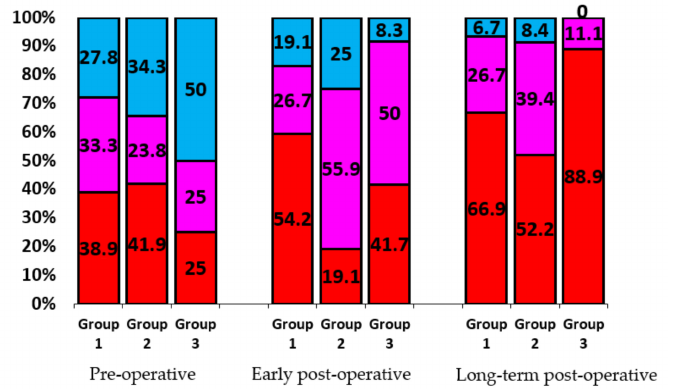
Figure 8. Heart remodeling versus type of mitral prosthesis (in %). Group 1 includes patients with bileaflet prostheses, Group 2—disc prostheses, Group 3—biological prostheses. Share of patients with Type I remodeling is indicated in red, Type II—pink, Type